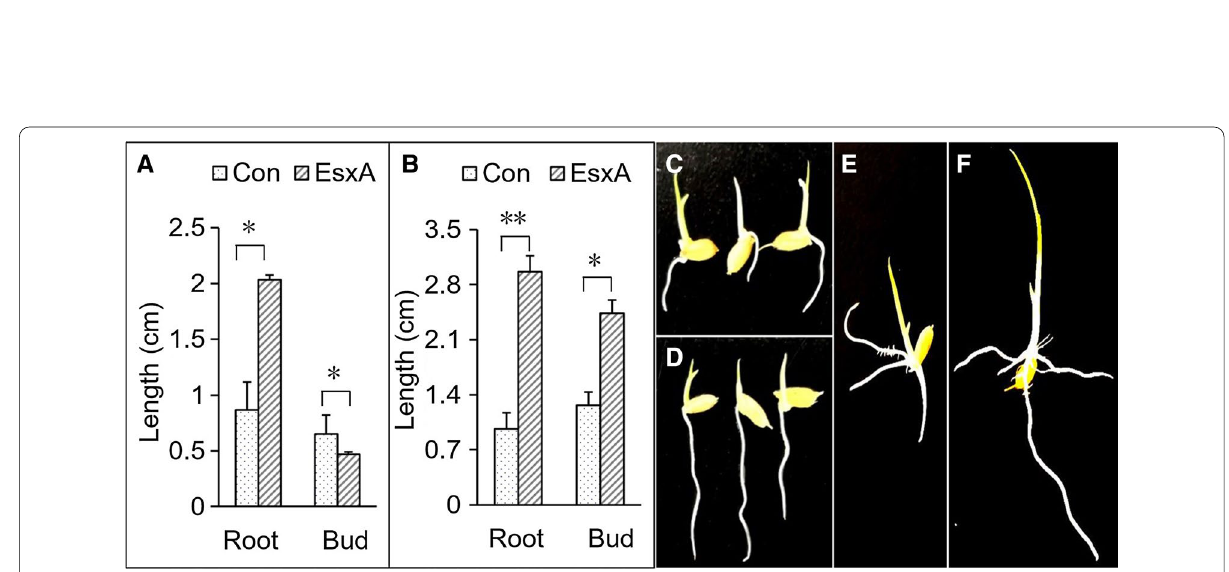
Fig. 6 Effects of EsxA on rice seedling growth. A : seed‑bud dipping experiment; B : seedling dipping experiment; C, D : control and EsxA treatments in the seed‑bud dipping experiment, respectively; E, F : control and EsxA treatments in the seedling dipping experiment. * and ** represents differences are significantly at the levels of P 0.01 and P 0.001, = =